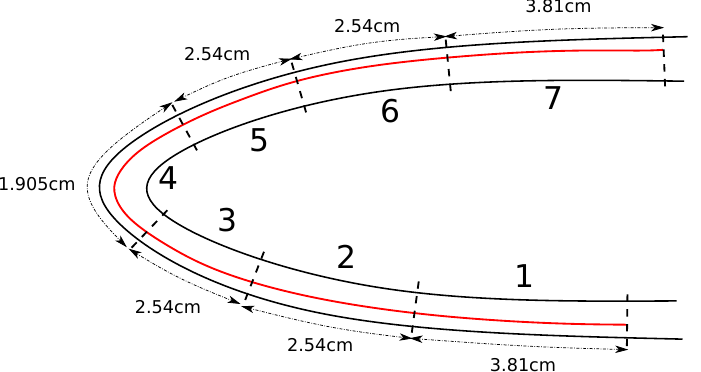
Figure 11. Illustration of the layout of the studied electrothermal